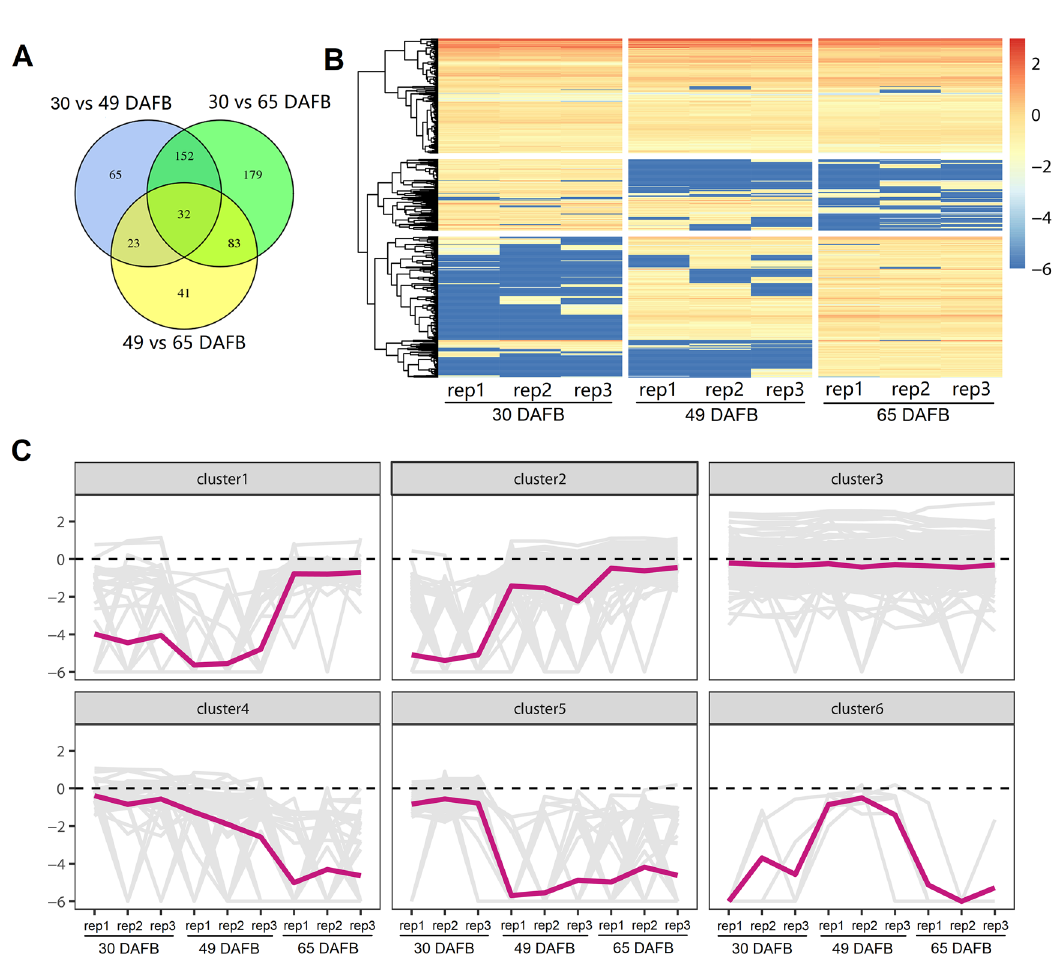
Figure 4. Overall view of the differentially expressed lncRNAs (DELs). Venn diagram ( A ), heatmap ( B ) and fitting curve ( C ) analysis of